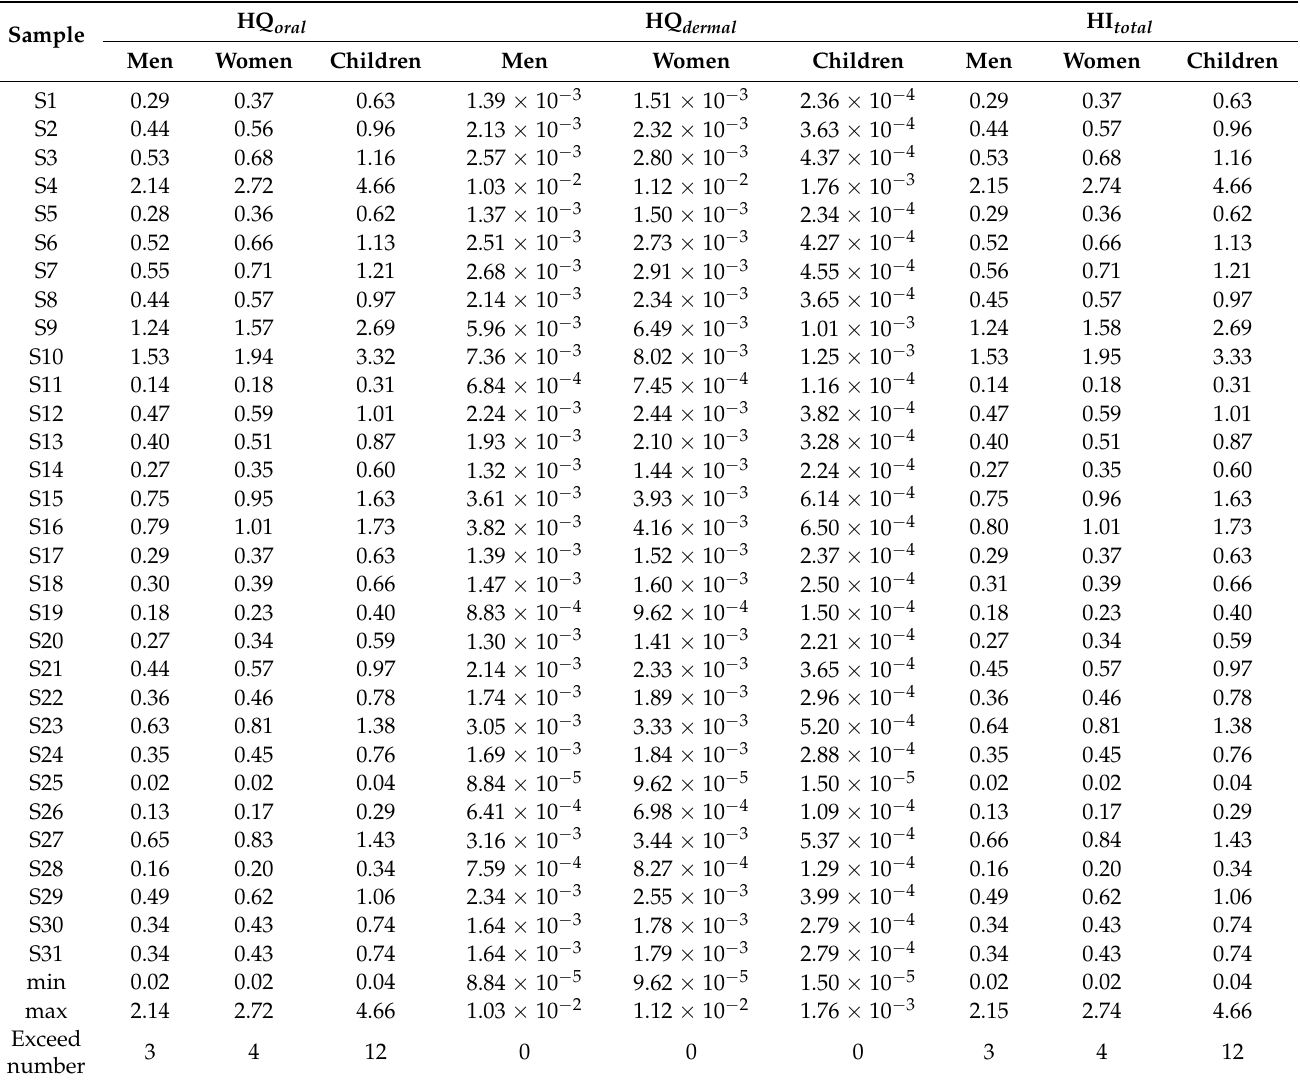
Table 5. Assessment results of health risks through drinking water intake and dermal contact.